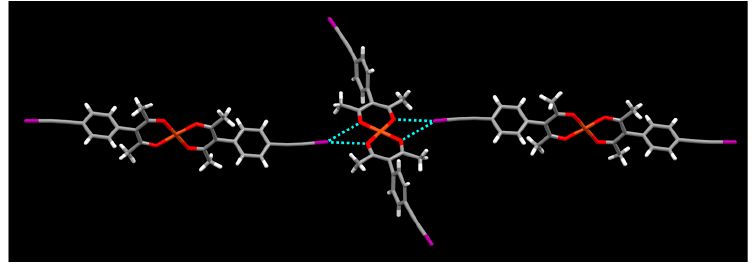
Figure 15. Bifurcated halogen···oxygen interactions in [Cu( L3 ) 2 ] (color codes: red—oxygen; purple—iodine; orange—copper).